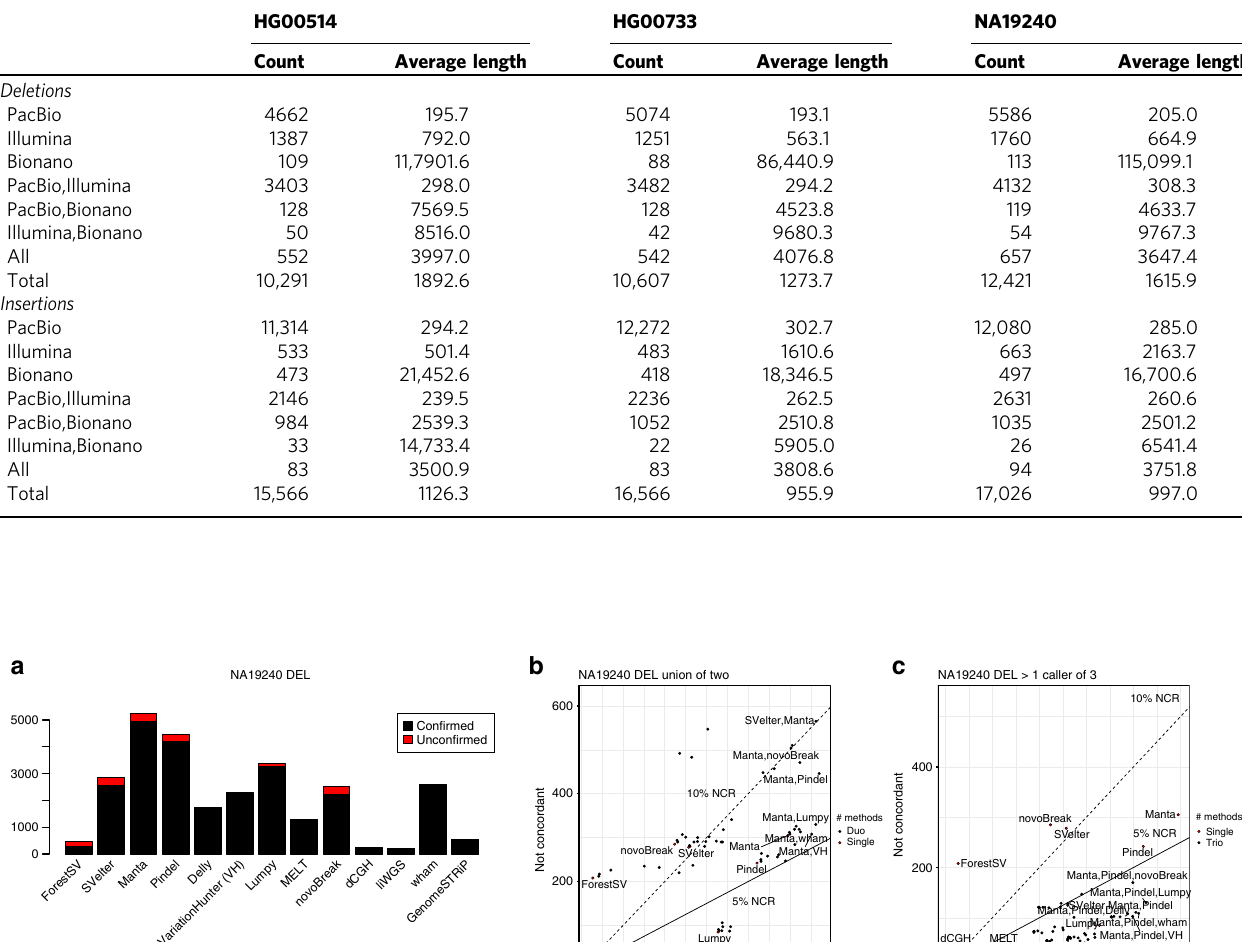
Table 2 Uni fi ed technology callset for copy number gain and loss structural variation